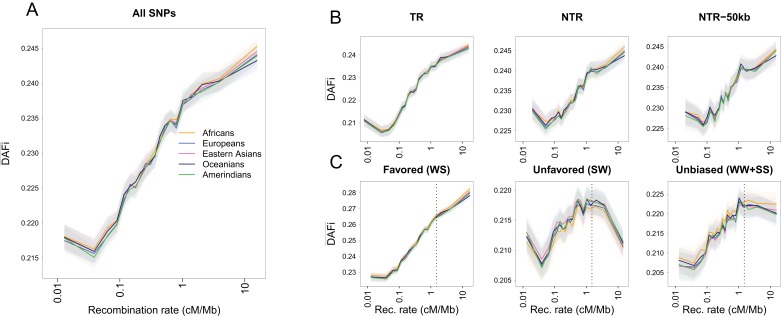
Same Figure and legend as Figure 1 but based on 20 SGDP individuals sequenced at high-coverage (Mallick et al., 2016).Note that DAFi¯ is larger than for 1000G (Figure 1). This is because this data sets has fewer rare alleles, as polymorphic sites are identified among 20 individuals only, as compared to 100 individuals for the SGDP data set. Shaded areas represent the 95% confidence interval of each group of individuals estimated using a block-bootstrap approach (see Materials and methods).